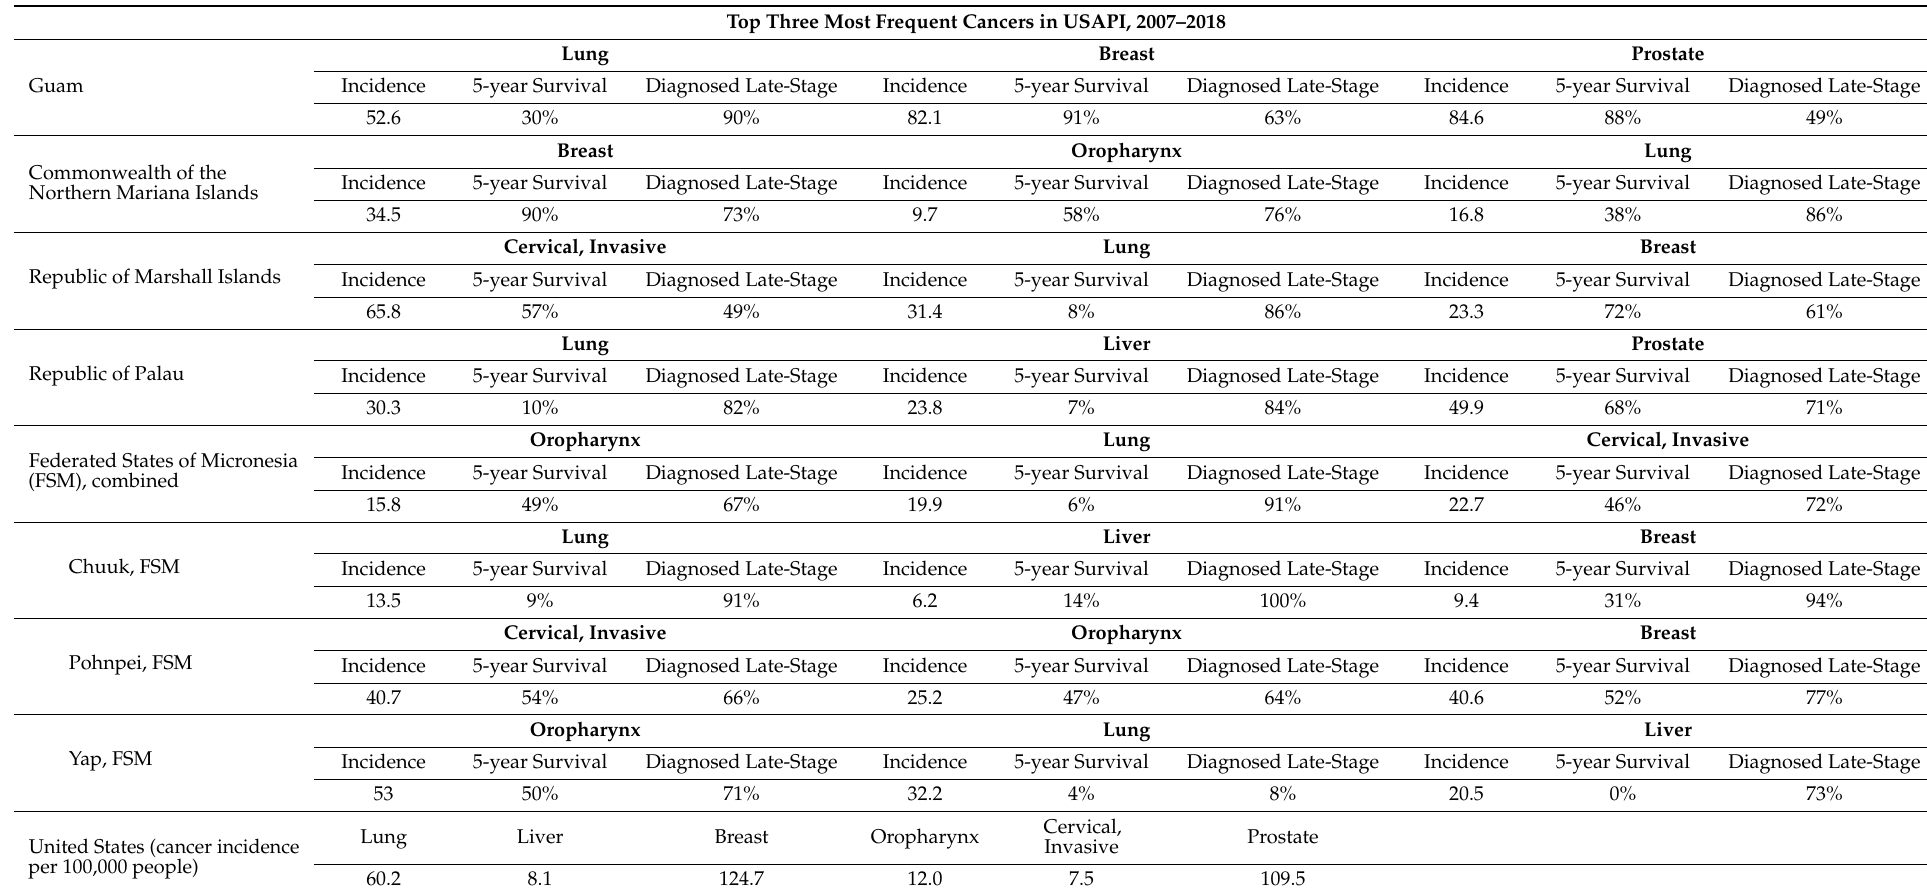
Table 1. Cancer incidence, 5-year survival, and % diagnosed late-stage based on the Pacific Regional Central Cancer Registry 2007–2018 data. Incidence rates are reported as incidence per 100,000 people, age-adjusted to the US standard population [18]. Top Three Most Frequent Cancers in USAPI,